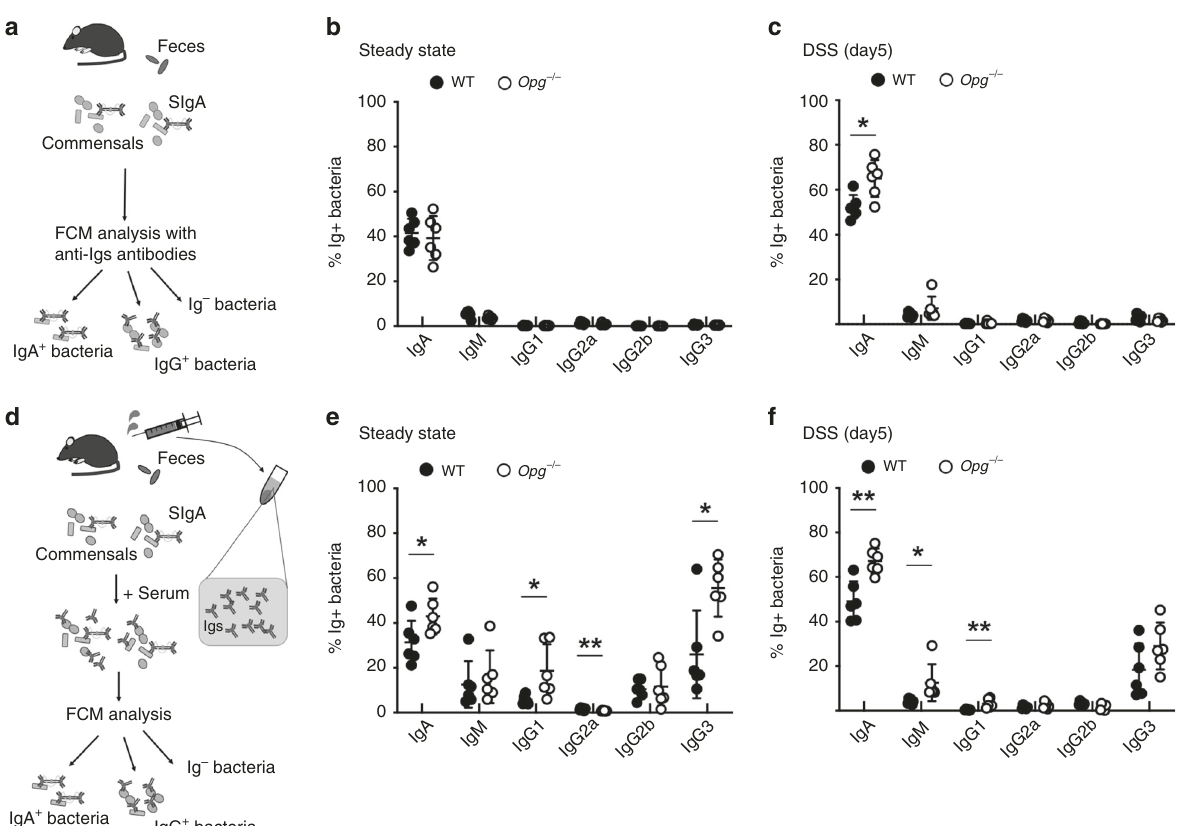
Fig. 8 Commensal-speci fi c antibody production is increased in Opg − / − mice. a , d Schematic cartoons depicting experimental designs. Commensal- speci fi c fecal or serum immunoglobulins were detected by fl ow cytometry. b , c , e , f Feces and sera were collected from Opg − / − or co-housed WT mice at day 0 ( b , e ) or day 5 ( c , f ) after the onset of DSS consumption. Flow cytometry assays of DAPI-positive fecal bacteria bound by the indicated Igs were performed without ( b , c ) or with ( e , f ) serum. Representative data from two independent experiments are shown as the mean ± standard deviation. * p < 0.05, ** p < 0.01 (one-way ANOVA, n = 6 animals). The source data underlying panels b , c , e and f are provided as a Source Data fi